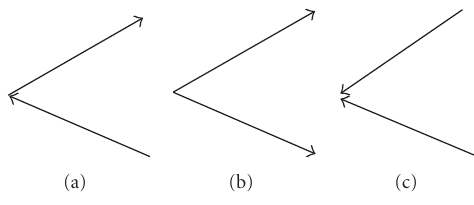
Figure 3: Relationship of three types of